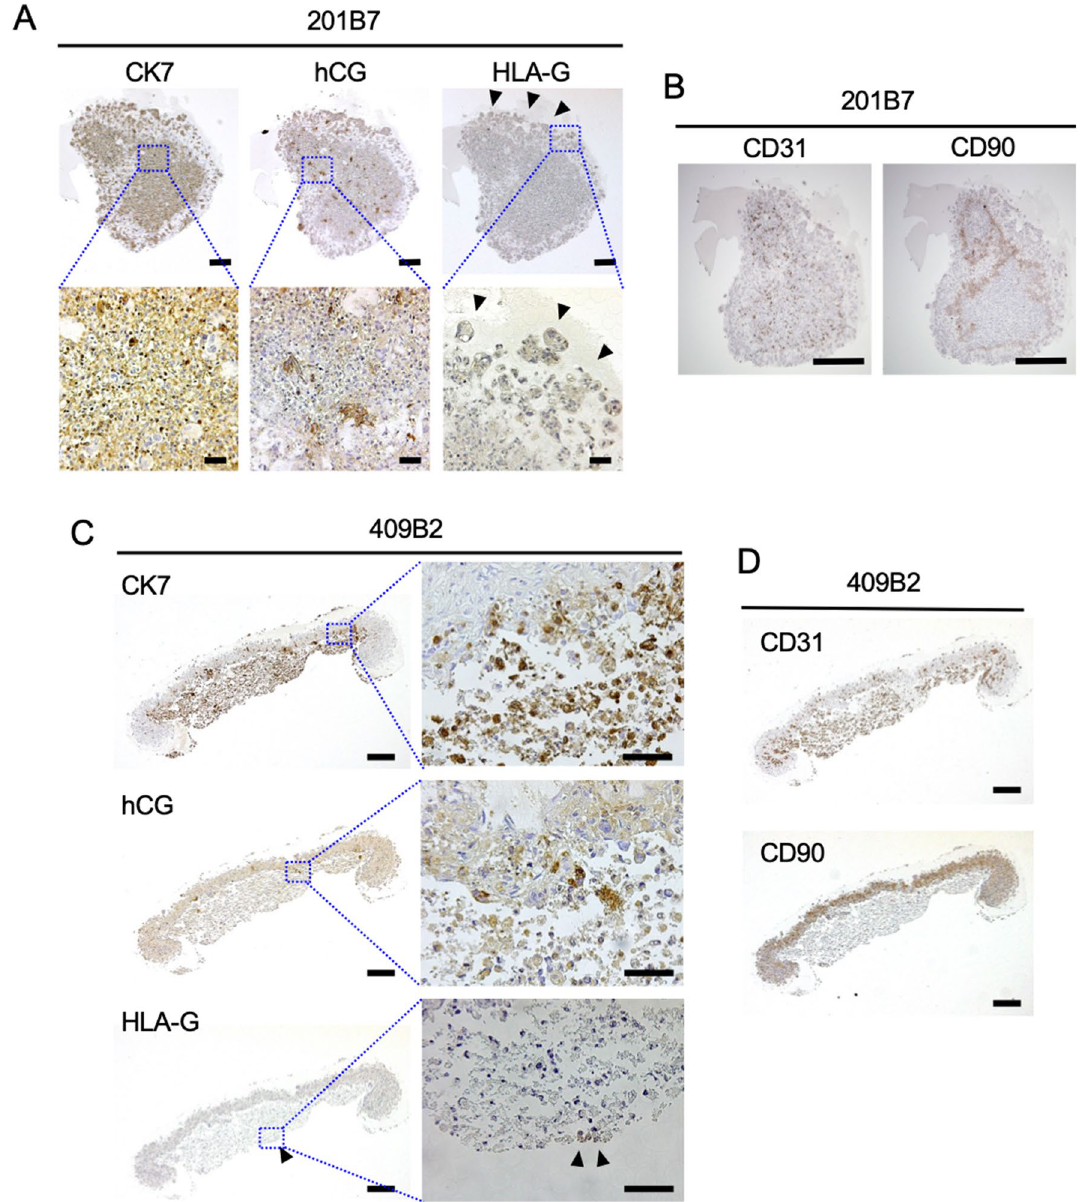
indicate staining for HLA-G. Bars, 250 μm in lower magnification and 50 μm in higher magnification. ( B , D ) Immunohistochemistry of CD31 and CD90 in an organ bud from 201B7 iPSCs ( B ) and 409B2 iPSCs ( D ). Bars, 500